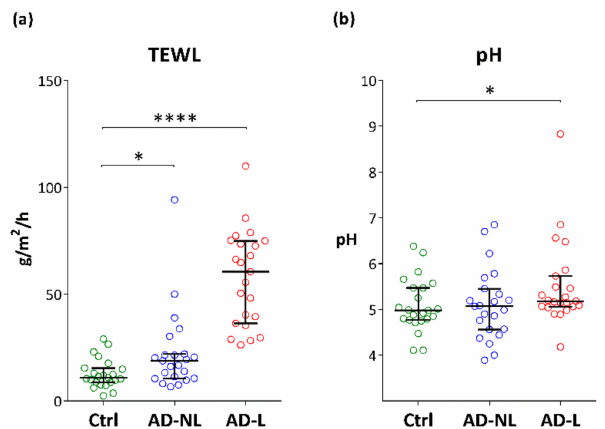
Figure 2. Trans-epidermal water loss (TEWL) ( a ) and pH ( b ) in healthy controls (Ctrl) and non-lesional (AD-NL) and lesional (AD-L) skin of AD patients. Data are shown as median with interquartile ranges. **** p < 0.0001, * p <